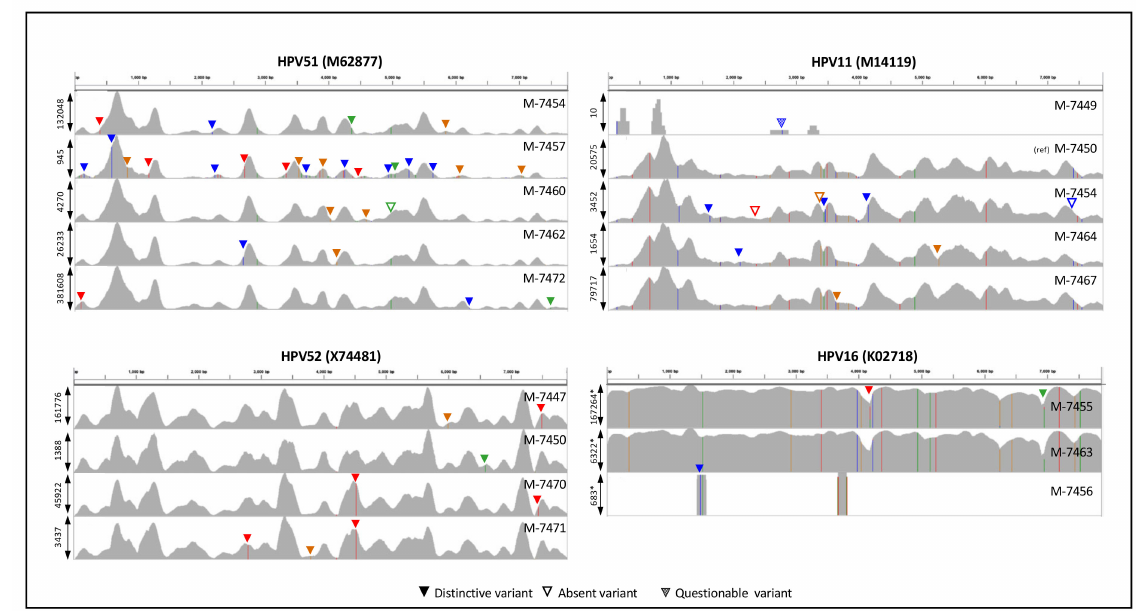
Figure 2. Comparison of mapped reads in different samples of 4 selected HPV types. Each panel shows the number of mapped reads (in vertical) of 5, 5, 4, or 3 samples detected in corresponding HPV types (NCBI accession number is shown). The vertical axis marked with “*” in HPV16 is shown in logarithm scale to clarify marked nucleotide variant sites. The peak number of reads per sample is shown at the left. The sample is shown at the right. Vertical lines in colors indicate sequence differences. Triangle marks show distinctive or absent variant